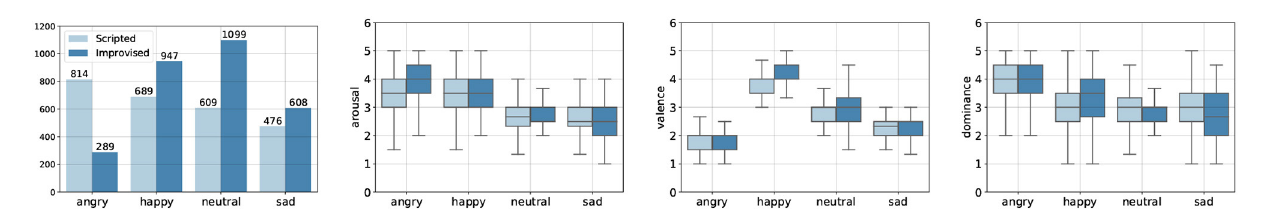
FIGURE6 Comparison of scripted (left) vs. improvised (right) sessions of IEMOCAP. A countplot for the 4-class classification problem used here is shown on the left. The three plots on the right illustrate the distribution of arousal (left) , valence (middle) , and dominance (right) gold standard annotations for scripted vs. improvised